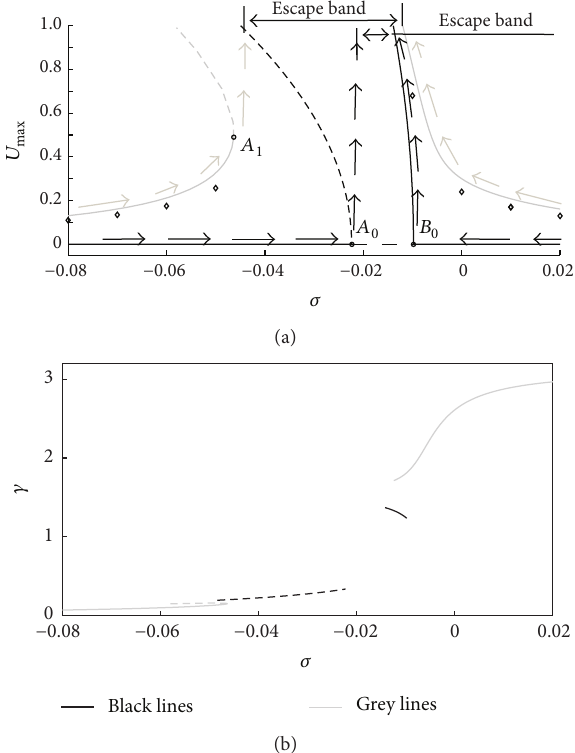
Figure 2: Frequency response of EA-MEMS-CR. AC frequency is near natural frequency. (a) Amplitude-frequency response and (b) phase-frequency response. 𝑈 max is the dimensionless amplitude of the free end, 𝜎 dimensionless detuning frequency equation (13), and 𝛾 dimensionless phase equation (18). Zero value for 𝜎 corresponds to natural frequency. Two methods are used, namely, MMS and two- term (2T) ROM. In both figures (a) and (b) two cases are shown: (i) soft AC with zero DC bias (black lines: MMS 𝛿 0𝐷 = 0.0) and (ii) soft AC with nonzero DC bias (grey lines: MMS 𝛿 0𝐷 = 0.001; ♢ 2T-ROM 𝛿 0𝐷 = 0.001). The AC voltage, fringe, and damping are 0.26, and 𝑐 = 0.01, respectively.